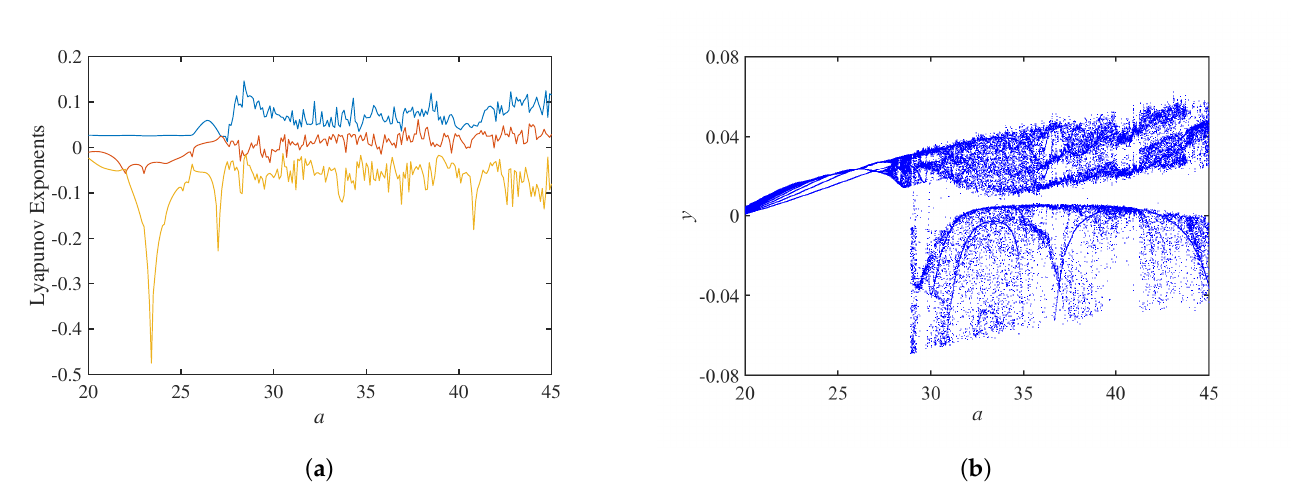
Figure 9. Dynamics analysis with parameter a : ( a ) Lyapunov exponents spectrum; ( b ) bifurcation diagram.